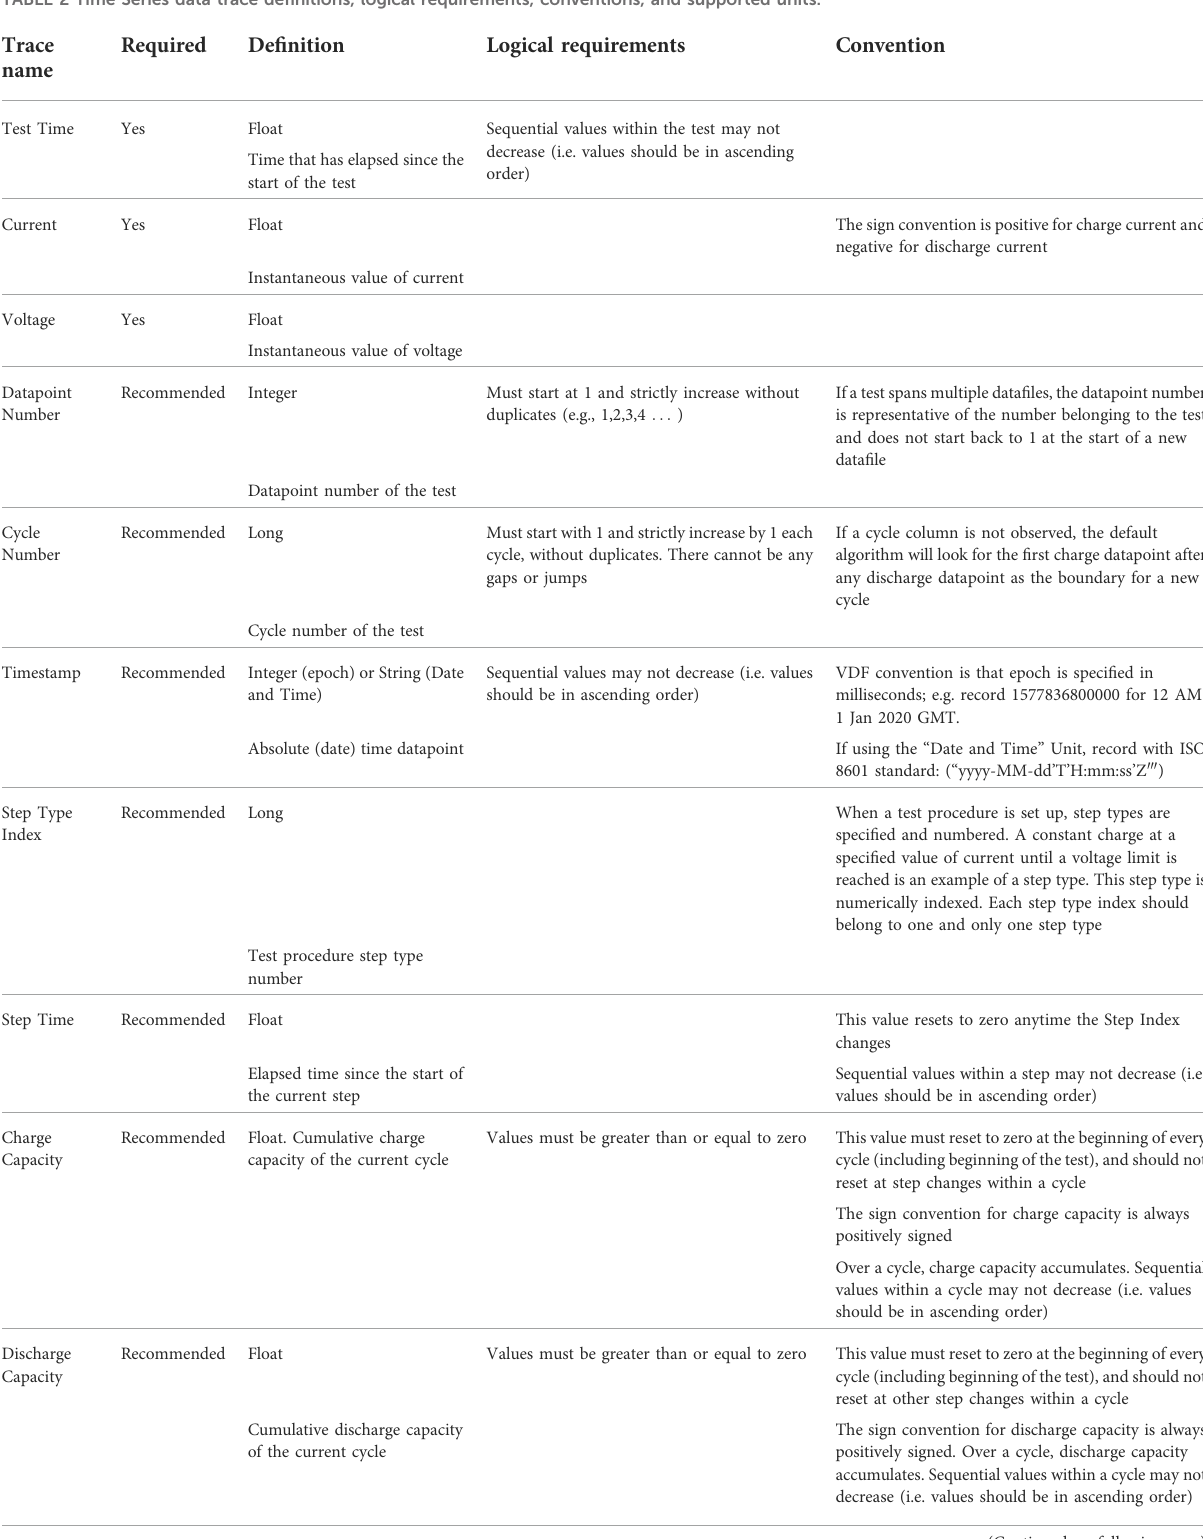
TABLE 2 Time Series data trace de fi nitions, logical requirements, conventions, and supported